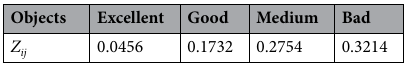
Table 3. Assessment criteria.